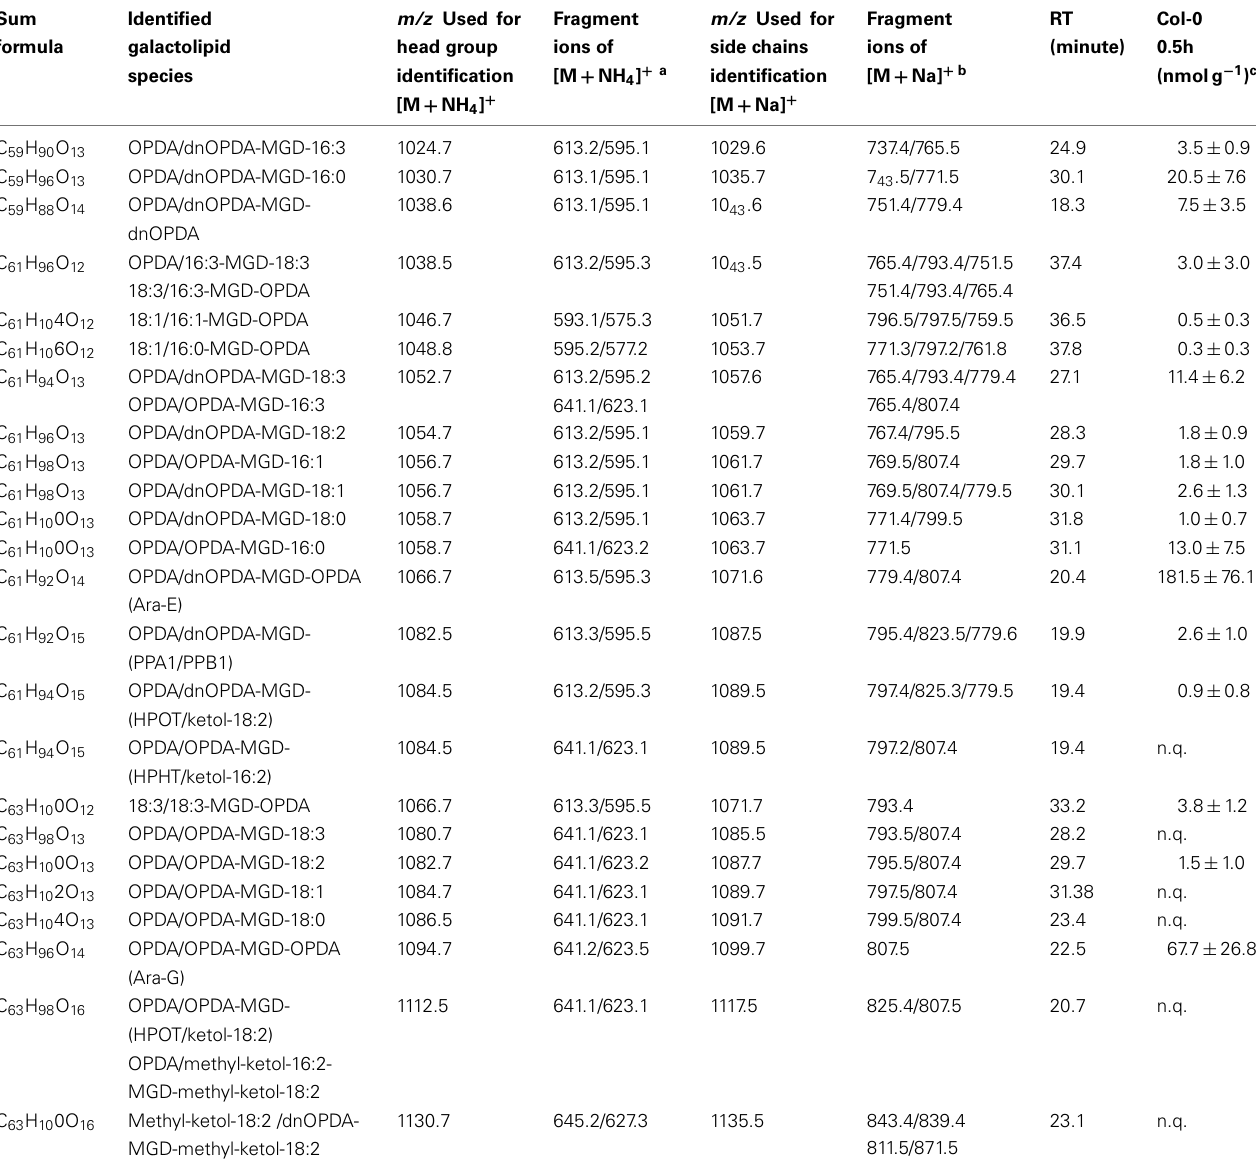
TableA6 | Oxidized acylated MGD species identified in wounded A. thaliana leaves. Sum